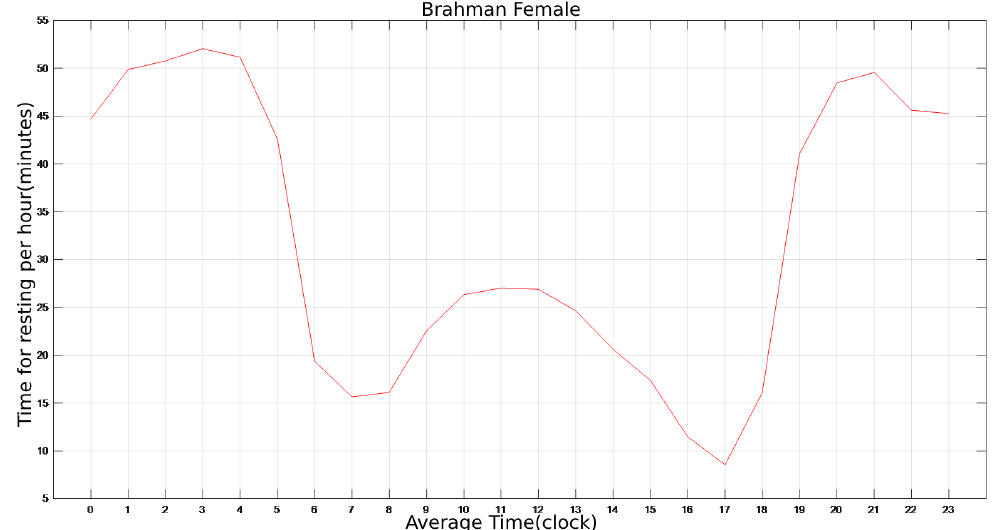
Figure 5. The average of one resting period for cattle(i.e., 24 h a day).